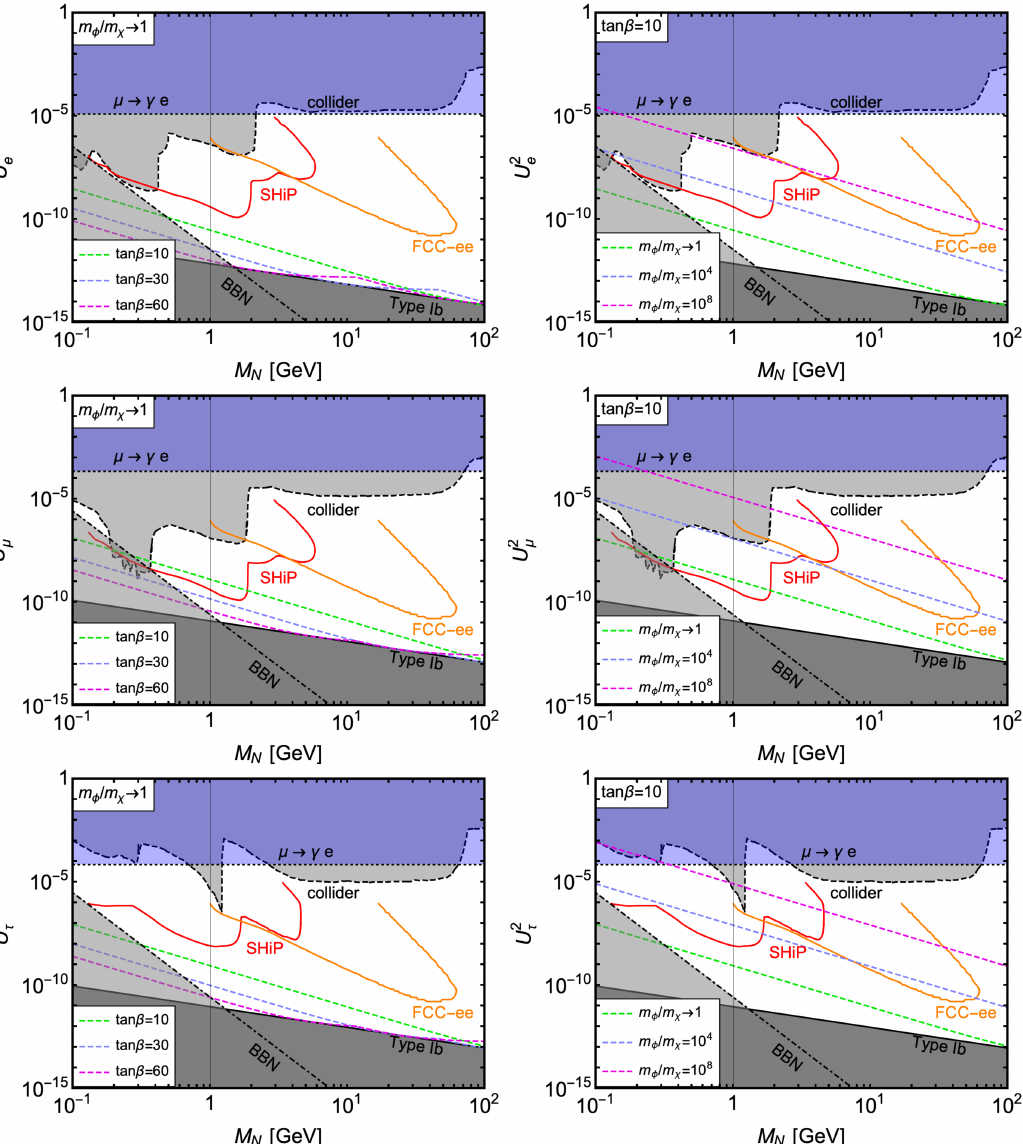
Figure 4 . Constraints and predicted dark matter dominance in the M N - U 2 type Ib seesaw model in which there is only a single heavy Dirac neutrino of mass M N . The correct relic abundance of dark matter can be produced over the entire white region. The left panels show the regions of definite dark sector dominance (meaning that the neutrino Yukawa couplings definitely do not play a role in dark matter production), which occurs in the white regions below the coloured dashed lines, for different values of tan β . The right panels show analogous regions for different ratios of dark particle masses. The black lines mark the constraints on the quantity U 2 in the type Ib model. The red and orange lines stand for the future sensitivity of SHiP [124] and FCC- ee